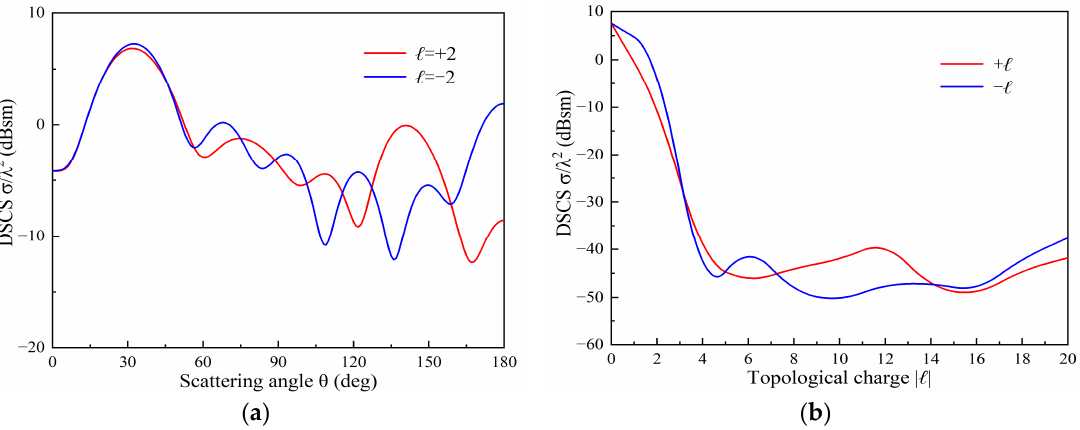
Figure 2. ( a ) Angular distributions of the DSCSs for a dielectric chiral sphere illuminated by LG twisted light with opposite topological charges (cid:96) = ± 2. ( b ) DSCSs at scattering angle θ = 180 ◦ for a dielectric chiral sphere illuminated by LG twisted light with topological charge | (cid:96) | from 0 to 20.